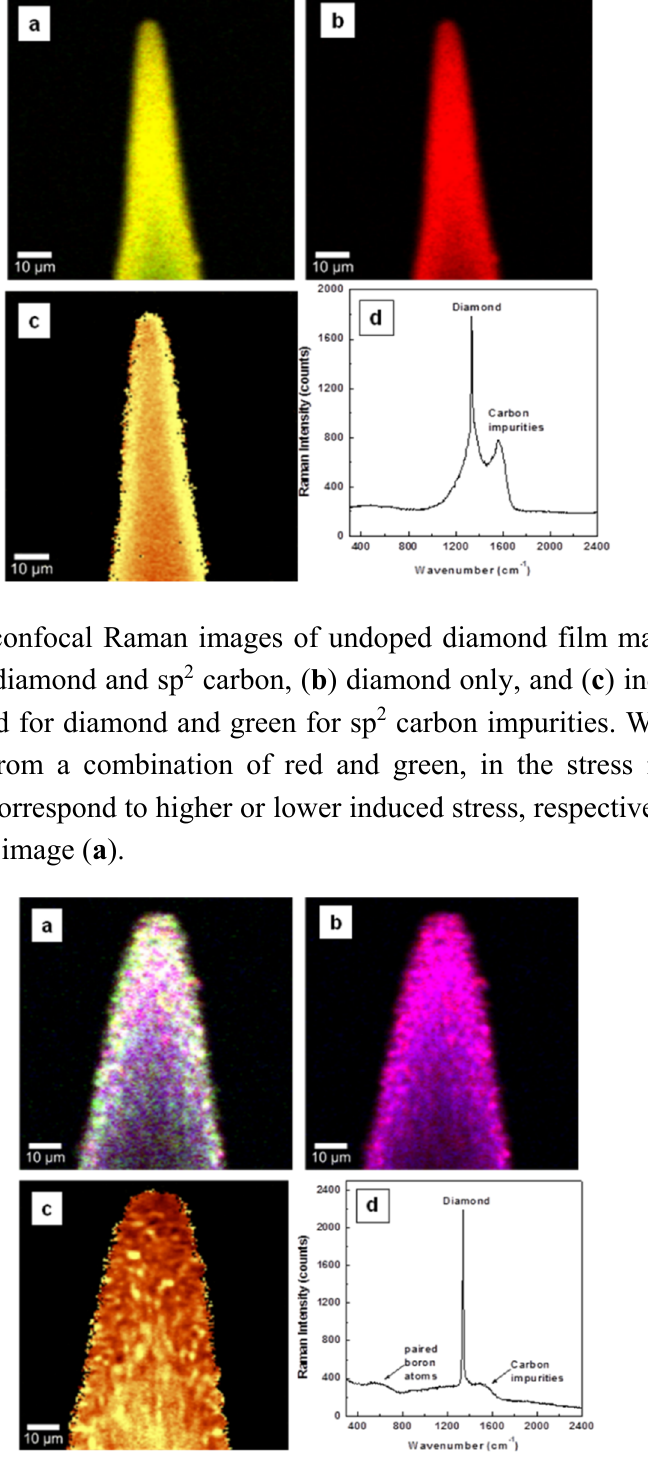
Figure 2. Surface confocal Raman images of lightly doped diamond film mapping the spatial distribution of: ( a ) diamond (red), boron incorporation (blue), and sp 2 carbon impurities (green), ( b ) diamond (red) and boron incorporation (blue), and ( c ) induced stress. Yellow pseudo-color in the stress image corresponds to higher induced stress. White, magenta, and turquoise colors observed in images ( a ) and ( b ) are due to combinations of red with blue and green, of red with blue, and of blue with green, respectively. ( d ) integrated Raman spectrum of image ( a